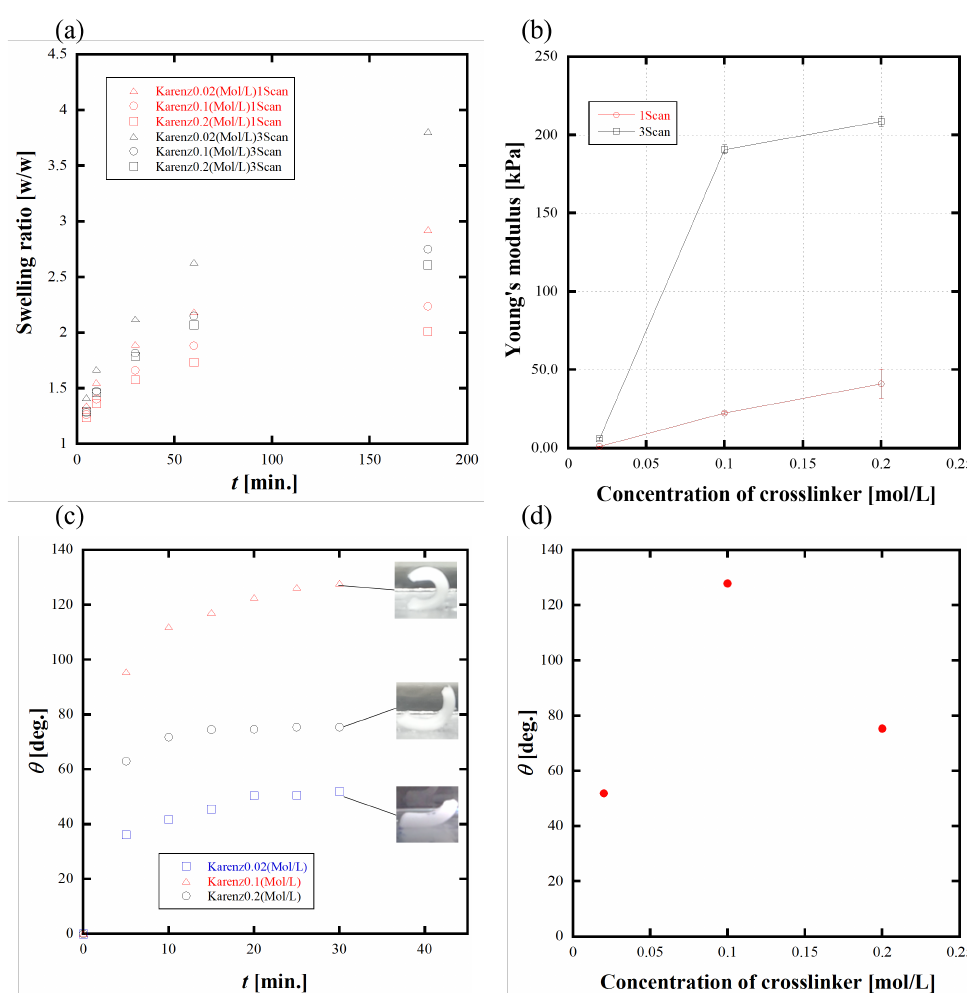
Figure 5. ( a ) The swelling ratio measurement as a function of time, in the various crosslinker concentrations and in the one or three scanning numbers of UV irradiation in 3D printing. ( b ) Young’s modulus measurement as a function of the crosslinker concentration, in the one or three scanning numbers of UV irradiation in 3D printing. ( c ) The degree of deformation measurement as a function of time in the various crosslinker concentrations. The inset photographs indicate the final states of deformation. ( d ) The bending angle vs. the concentration of the crosslinker Karenz